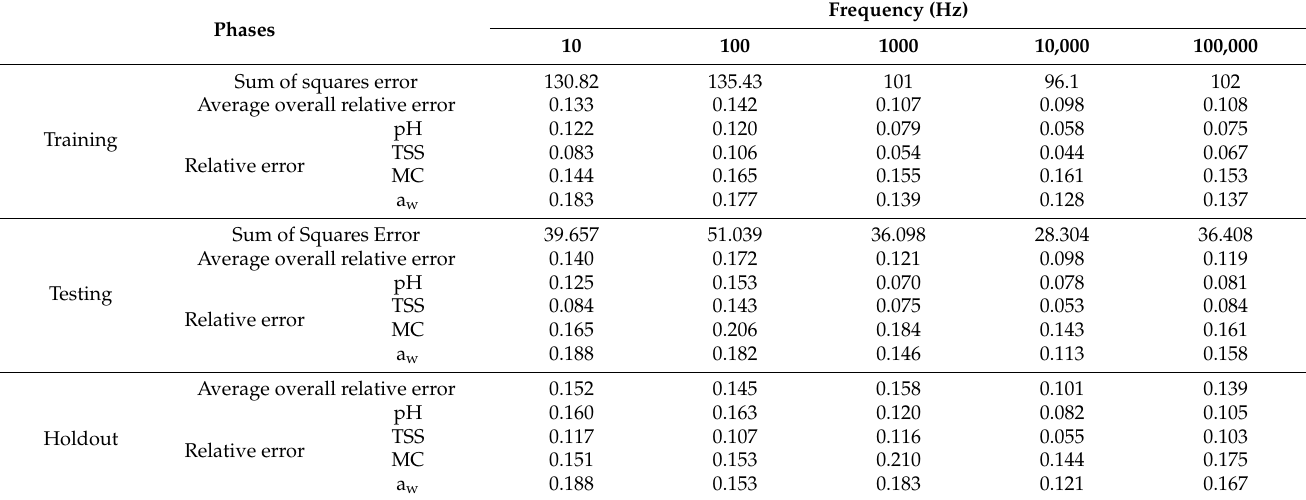
Table 6. A comparison between the ANNs models’ errors in the training, testing, and holdout phases at various